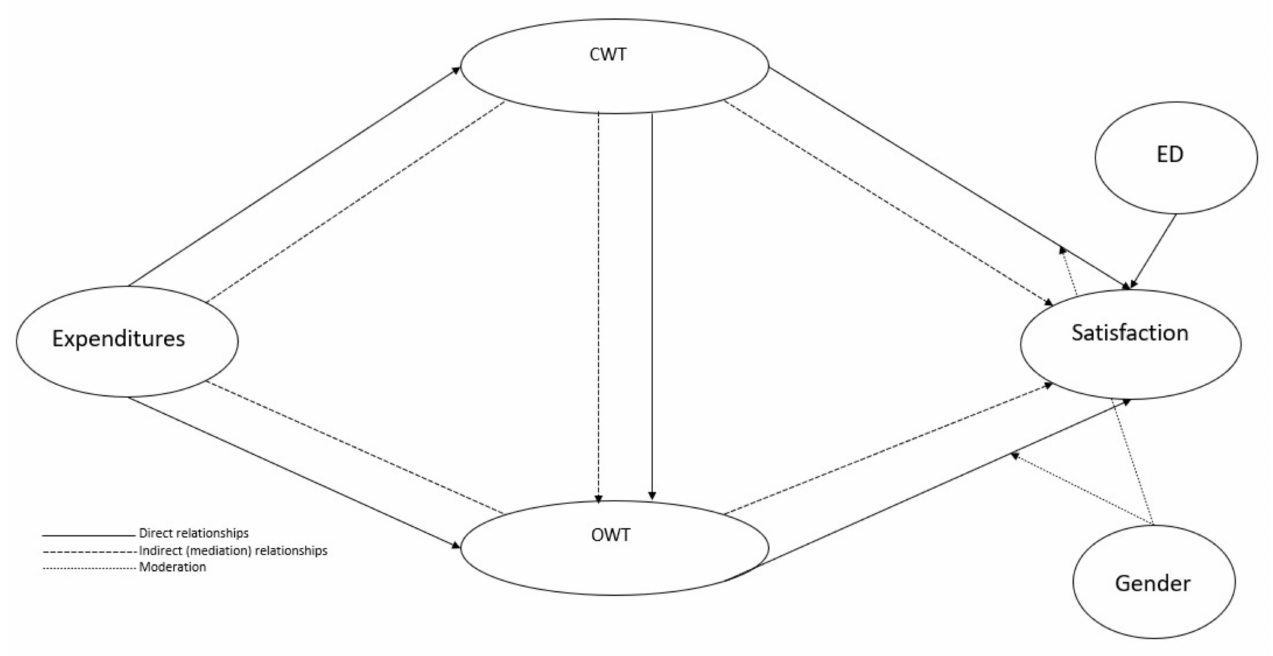
Figure 1. Conceptual model and